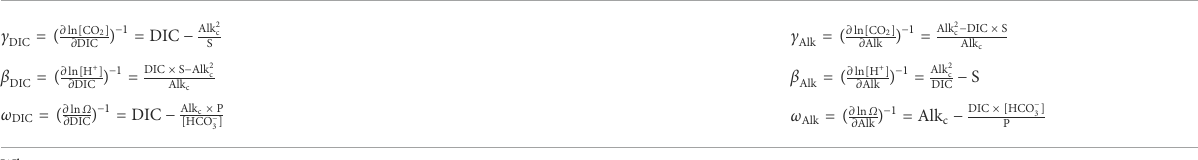
Response of buffer factor to changes in DIC Response of buffer factor to changes in Alk